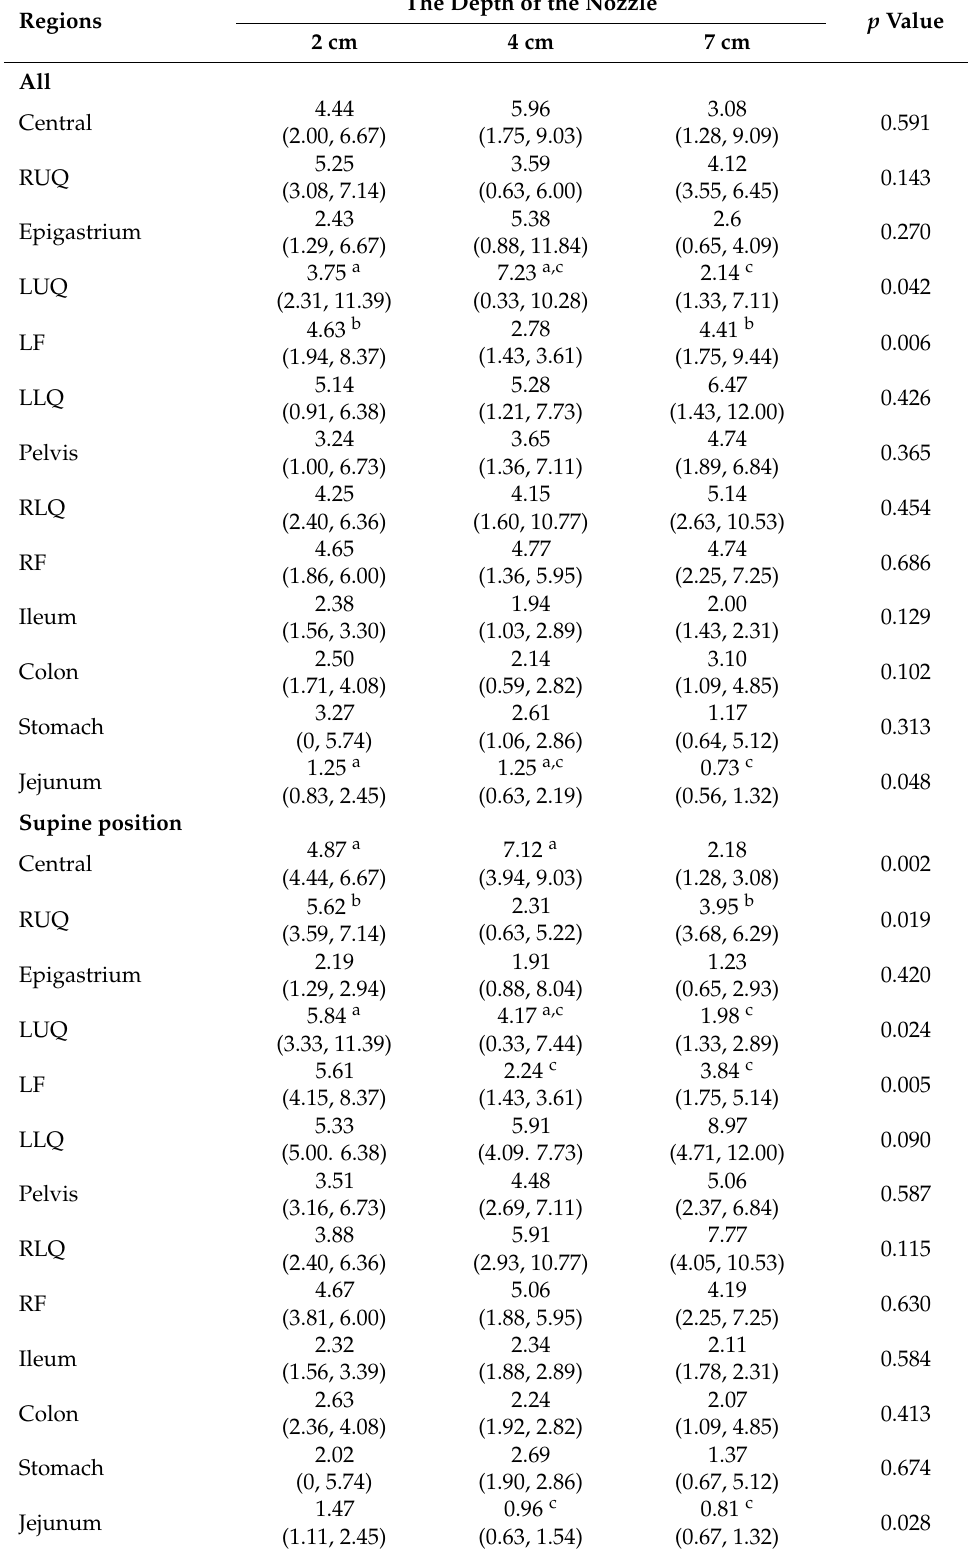
Table 2. Comparison of the penetration depth of 1% methylene blue among 2, 4, and 7 cm depth of the nozzle in 13 regions of the pigs’